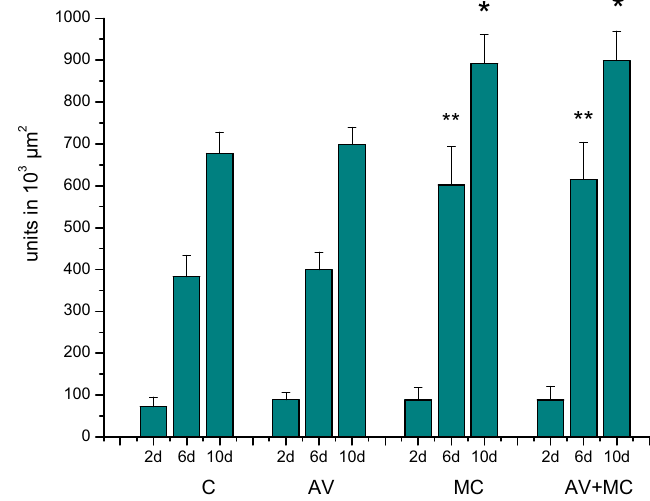
FIGURE 4 – Number of cells detected by 10 3 µm 2 of healing area in the region of the skin wound experimentally induced in normal 120-day-old Wistar rats after 2, 6 and 10 days of treatment. C: control; AV: animals topically treated with Aloe vera ; MC: animals treated with microcurrent (10 µA/2 min); AV+MC: animals receiving topical application of Aloe vera plus microcurrent (10 µA/2 min). Values are reported as means ±SD. ** and * represent p<0,05